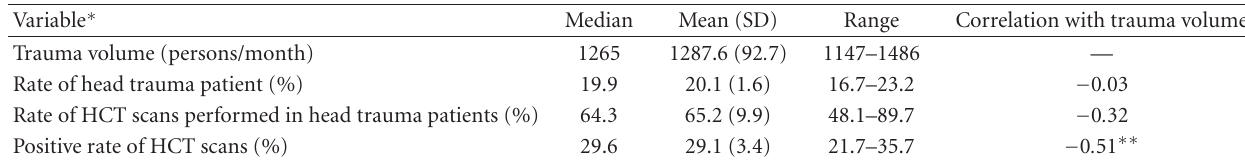
Table 2: Characteristic data of trauma patients on a monthly basis ( n = 20). Univariate correlation analysis showed an inverse weak correlation between trauma volume and positive rate of head CT scans. There was no significant correlation noted between trauma volume and the other two proportions.